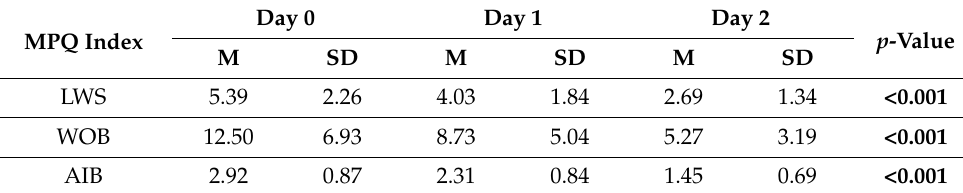
Table 5. The intensity of postoperative pain in the days following the